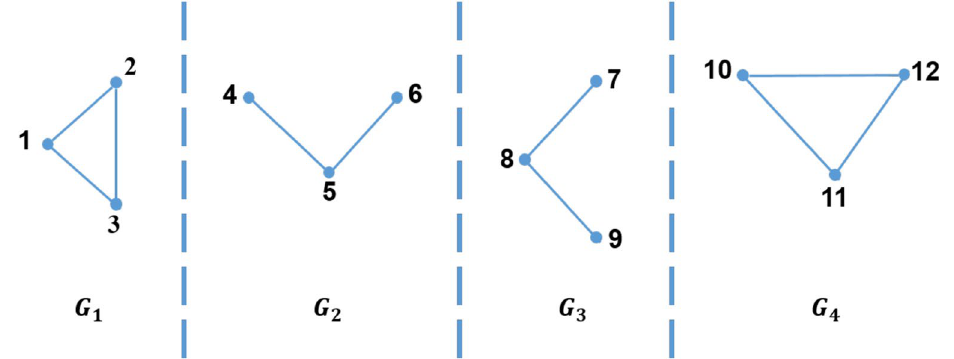
Figure 3. 1-partition of the graph in Fig. 2.